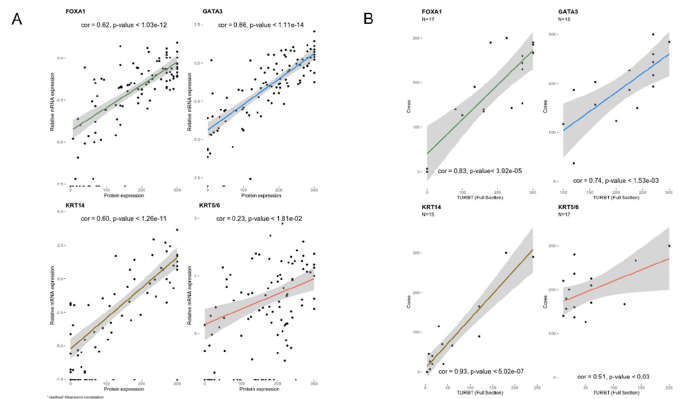
Figure 1. ( A ) Comparison of the results of immunohistochemistry (IHC) findings and Nanostring expression for the markers used for the tumor subtype classification shows an excellent correlation between both assays. ( B ) Comparison of the histoscore of tissue microarray (TMA) cores with full block